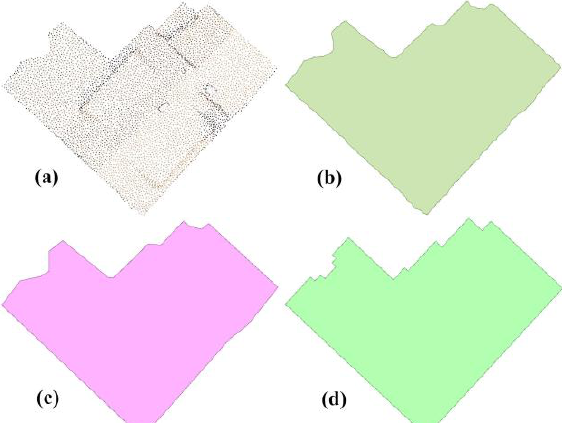
Figure 3. The results of building outline extraction obtained by the direct approach for the selected building: (a) a point cloud of the building; (b) a convex hull; (c) a generalised outline; (d) a regularised